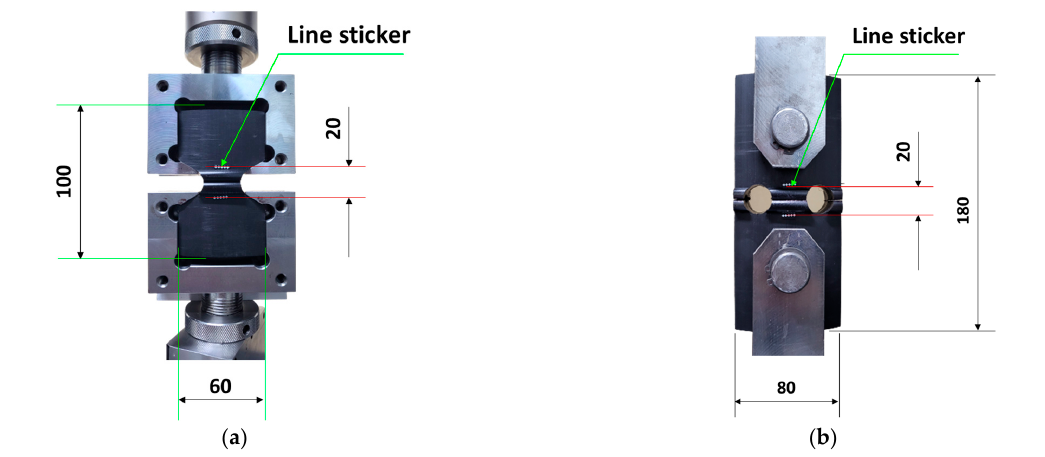
Figure 2. Grip-specimen assembly showing the line sticker gage location for optical measurement (unit: mm): ( a ) TWT test; ( b ) WT test.